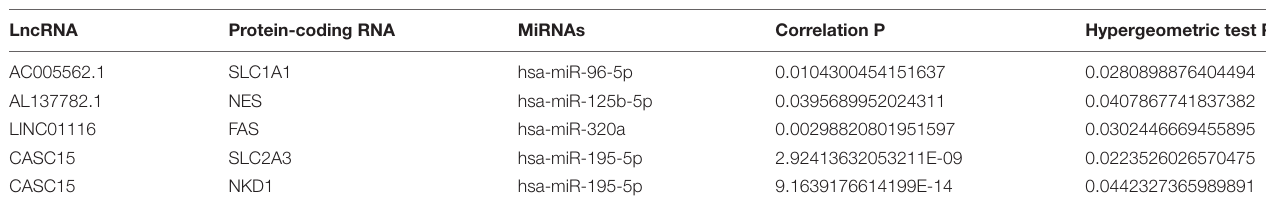
FIGURE 3 | The ceRNA network constructed for distance metastasis colon carcinoma (A) and the Kaplan–Meier survival curves of the important members of the ceRNA network (B,C) . TABLE 1 | Hypergeometric testing and correlation analysis results of ceRNAs